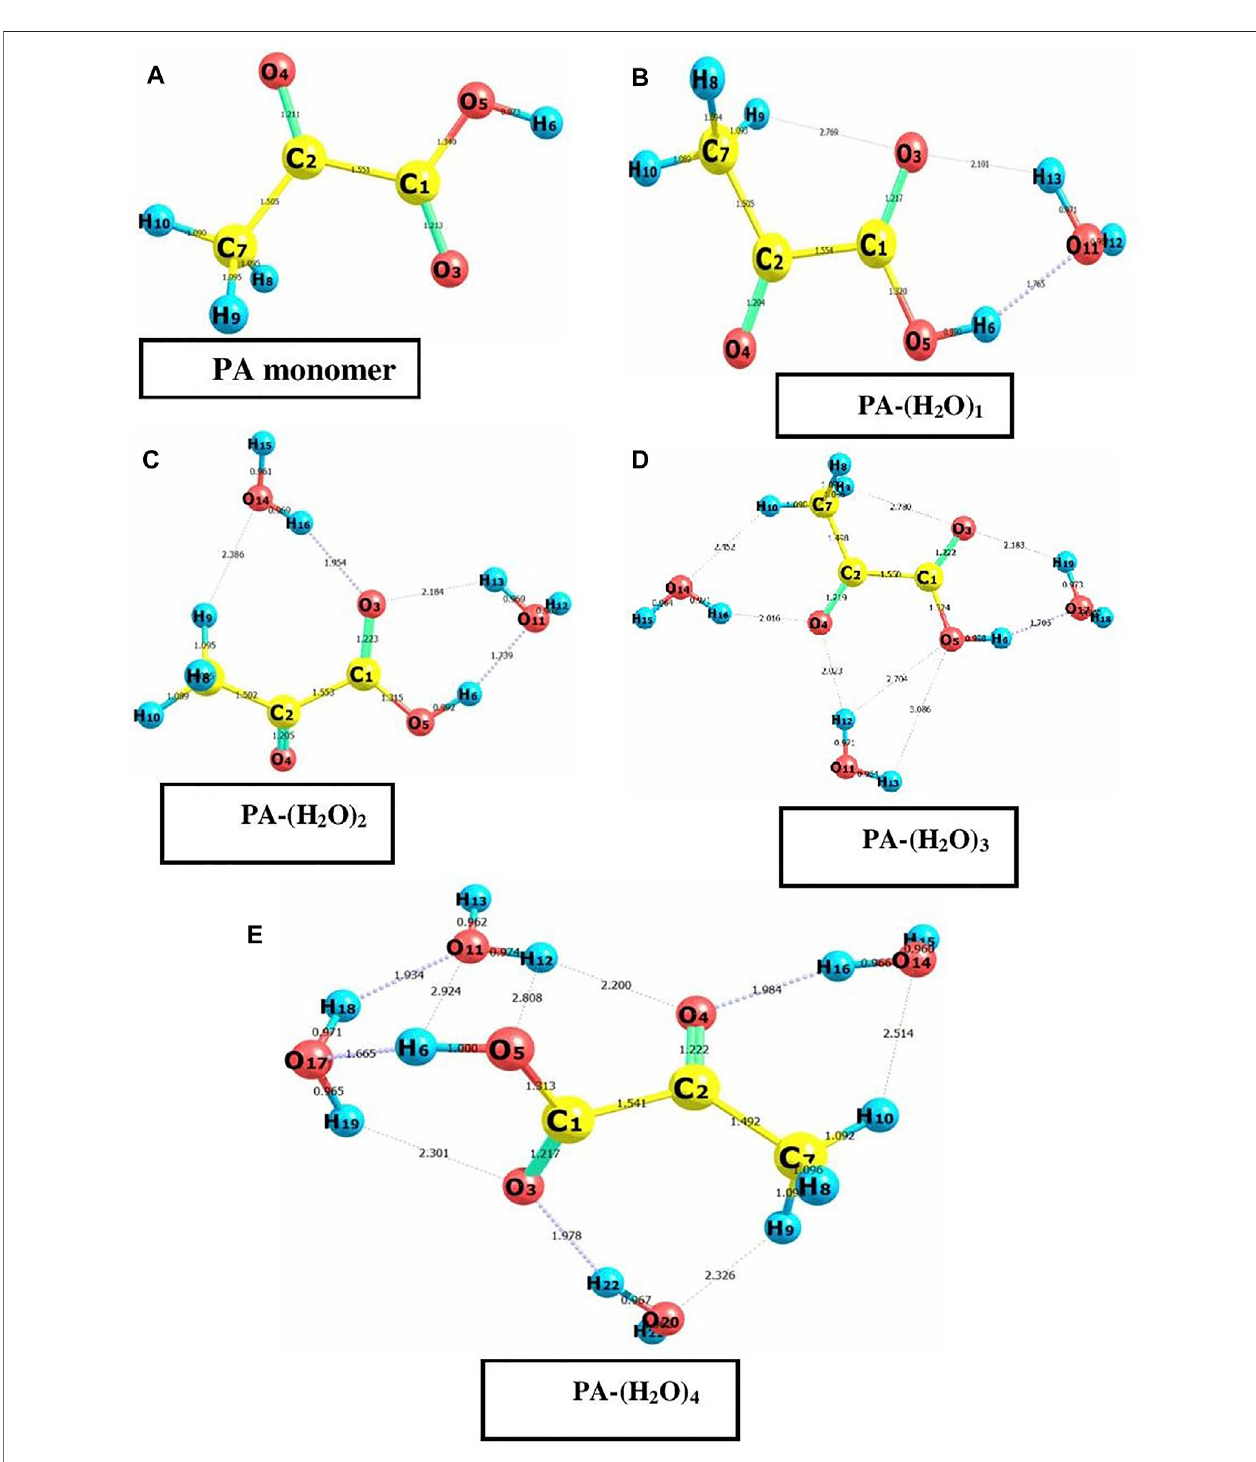
FIGURE 1 | Optimized geometrics of pyruvic acid monomer and PA-(H 2 O) n = 1 – 4 (A – E) complexes with atom numbering using DFT/B3LYP calculations at the 6- 311 G++(d, p) basic set.